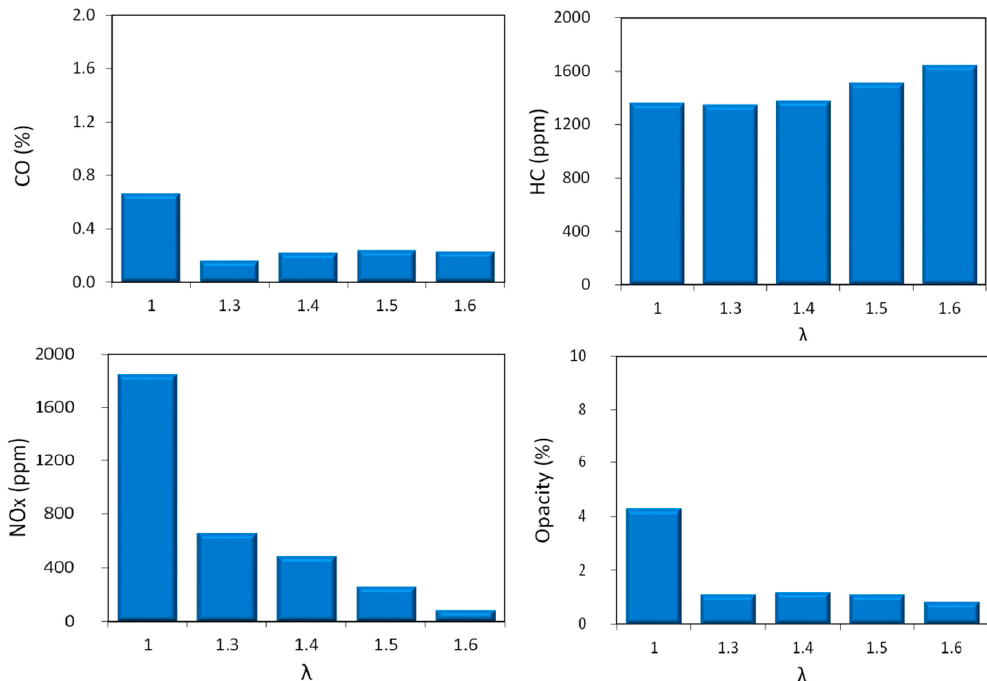
Figure 9. Exhaust gas emissions for different air–fuel ratios.